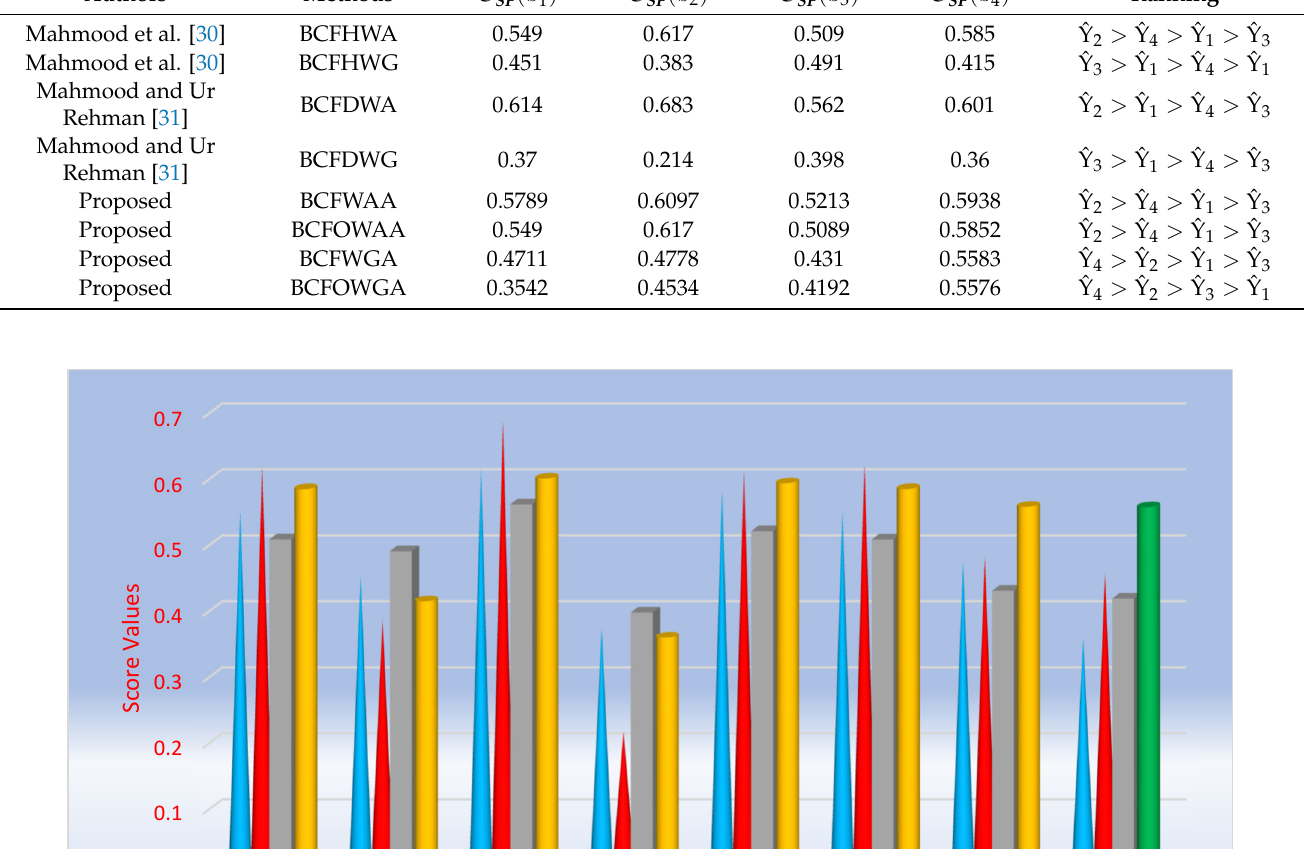
Table 9. Comparative analysis of the proposed work.